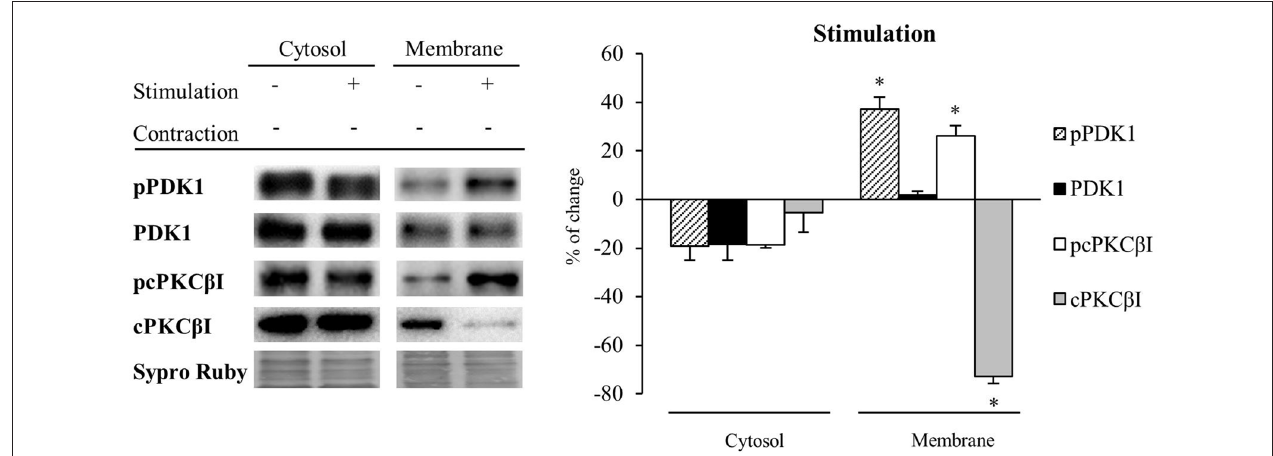
FIGURE 5 | Synaptic activity increases pPDK1 and PCK β I in the membrane fraction of skeletal muscle. Western Blot of PDK1 and pPDK1 after isolation of membrane and cytosol fractions in presynaptic stimulation treatment at 1 Hz stimulation for 30 min. Presynaptic stimulation has been simplified as Stimulation . Each column has been compared to its respective control (see Table 1 ). Results showed that synaptic activity does not affect significantly the level of any protein in the cytosol. Therefore, the ratios pcPKC β I/cPKC β I and pPDK1/PDK1 remain the same. However, both pPDK1 and its substrate, pcPKC β I were significantly increased in the membrane fraction. Thus, both ratios pcPKC β I/cPKC β I and pPDK1/PDK1 were increased indicating that synaptic activity specifically enhances phosphorylation of PDK1 and cPKC β I. Data are mean percentage ± SEM, ∗ p < 0.05 ( n = 5). Abbreviations: phosphoinositide-dependent kinase 1; pPDK1, phosphorylated